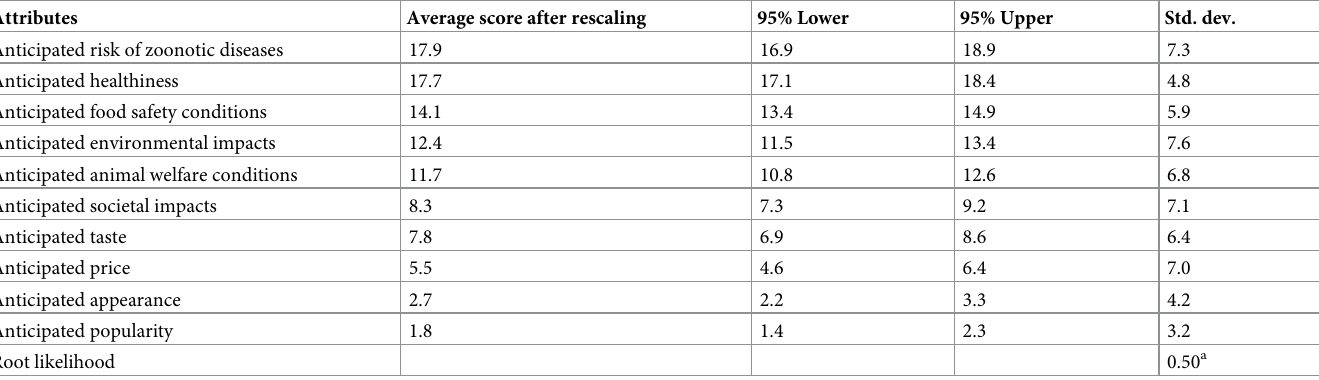
Table 3. Results of the Hierarchical Bayes (HB) analyses after rescaling the raw scores from 0 to